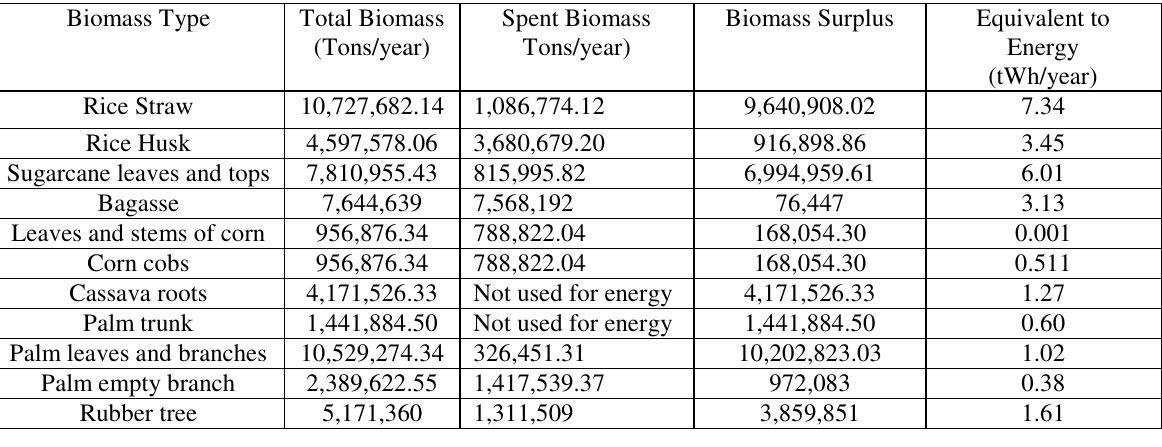
Table 5: Potential of Biomass Sources in